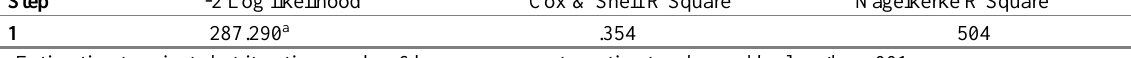
Table 5: Hosmer and Lemeshow Test